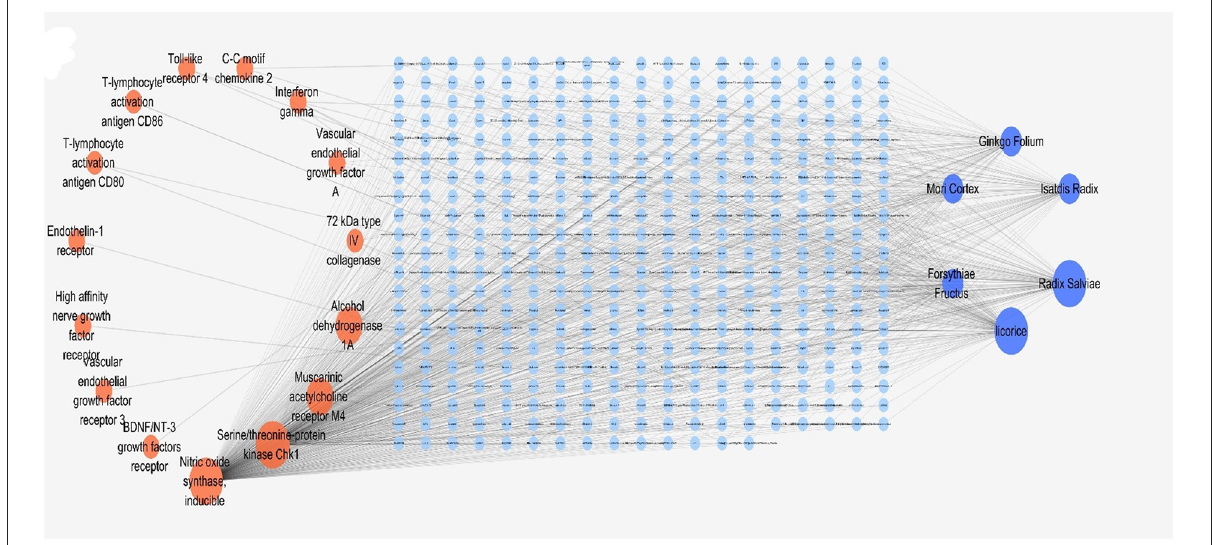
FIGURE2 The predicted “target-component-TCM” network. The orange dots were the effective targets, the dark blue dots were the six Chinese medicines obtained by reverse screening, and the light blue dots were the components of Chinese medicines.